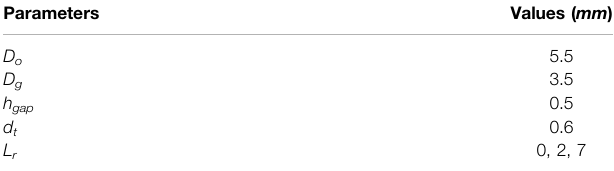
TABLE 1 | Dimensional parameters of the injector.